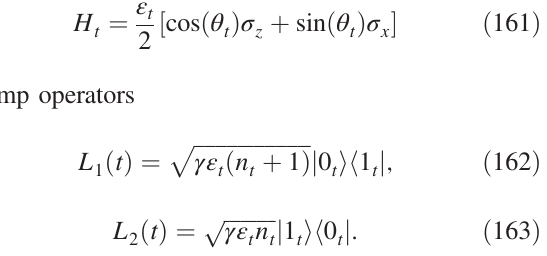
≥ t and (d),(g) finite-time Landauer principle c; 1 c; 2